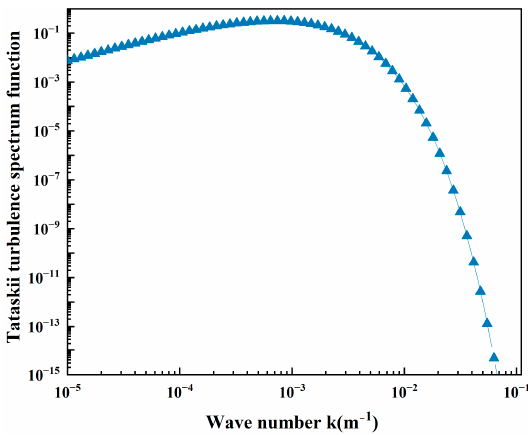
Figure 2. Tatarski turbulence spectral function.